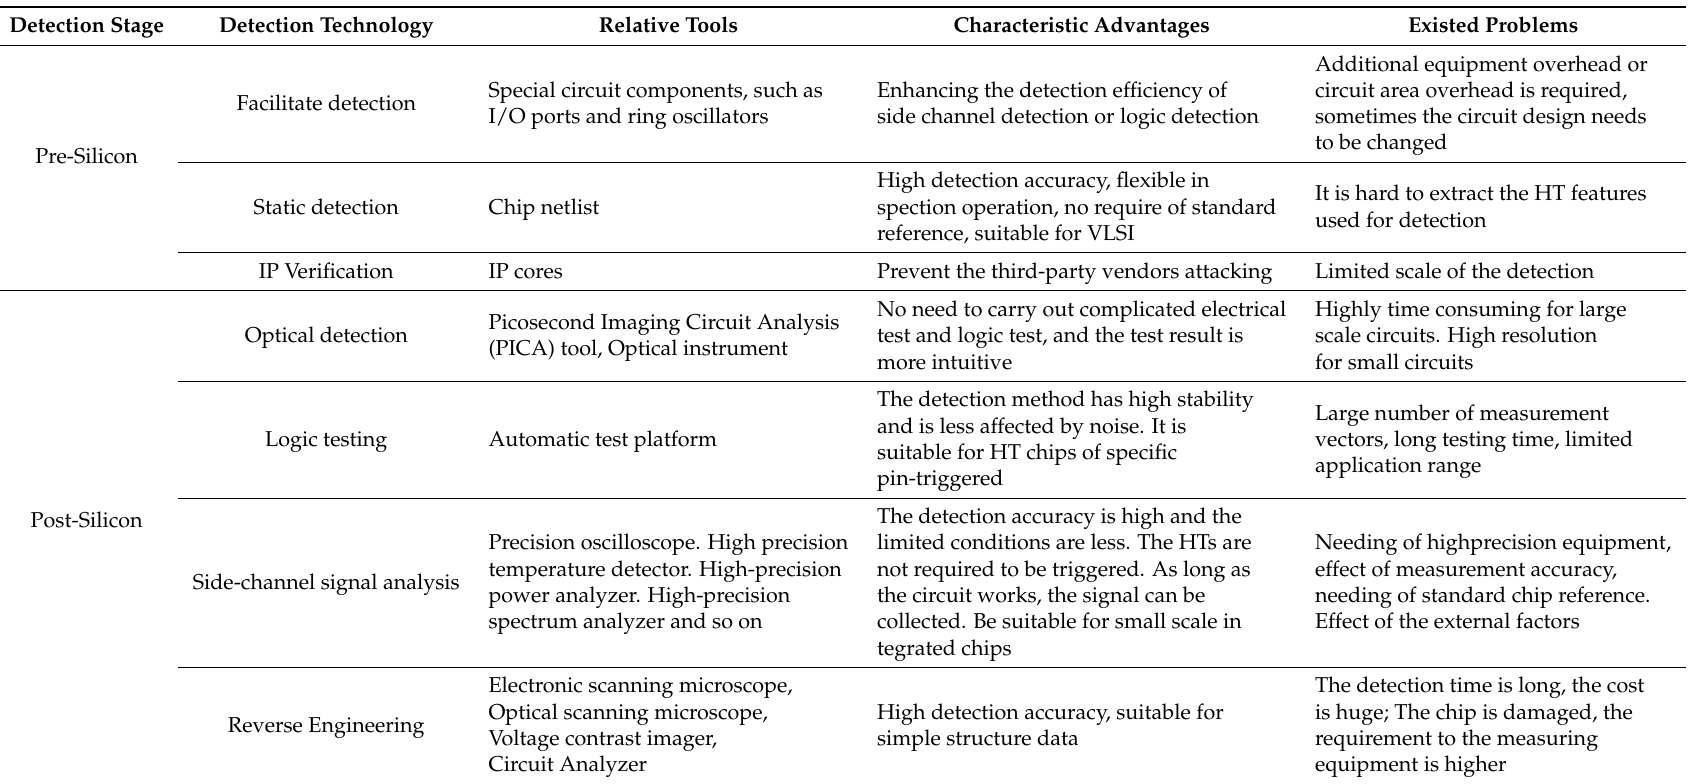
Table 3. HTs detection techniques